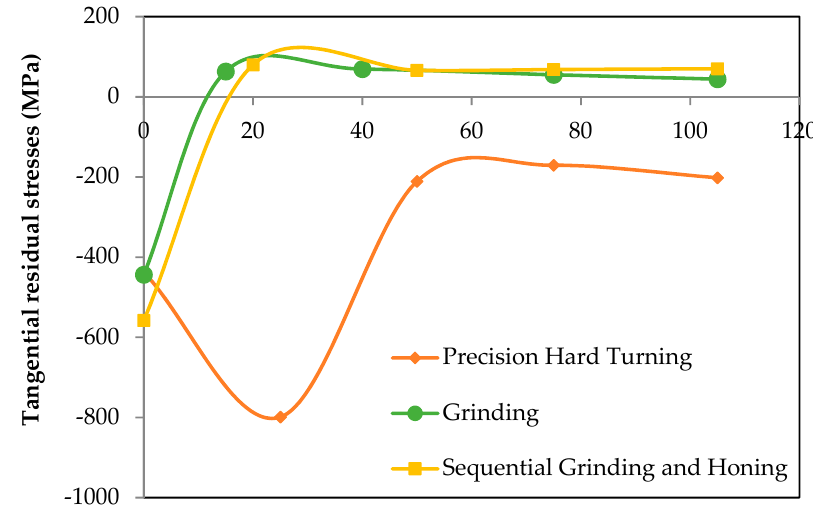
Figure 8. Residual stresses in tangential direction.